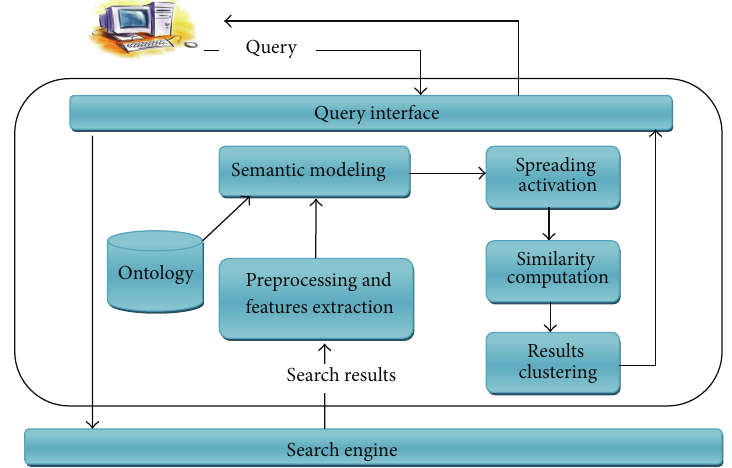
Figure 1: System overview.